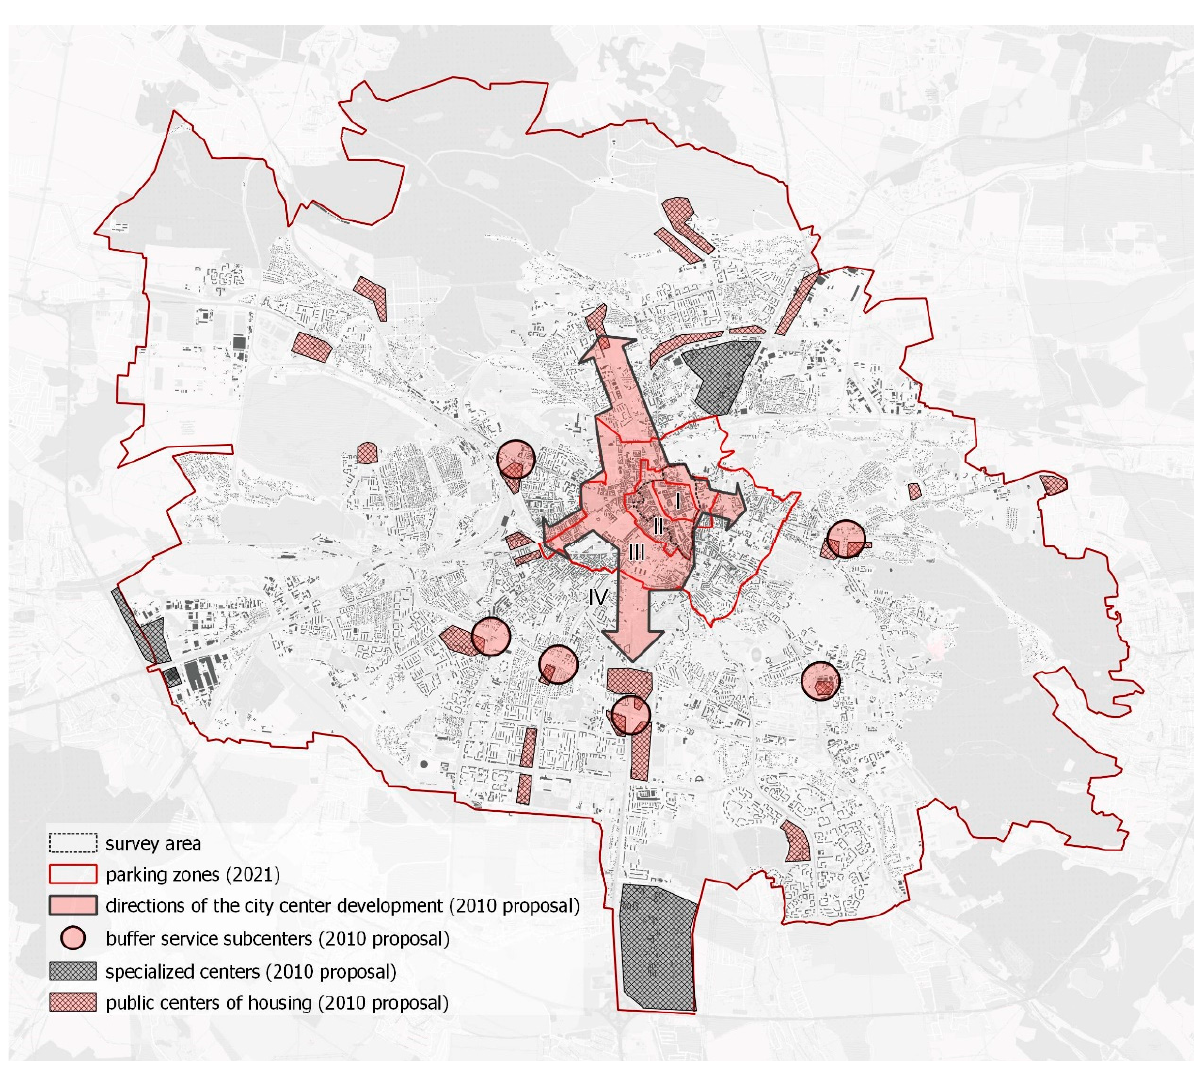
Figure 13 . The directions of territorial development of the city center according to the master plan of Lviv for the period of 2010–2025. The scheme was prepared by the authors using the master plan [68]. The growing density of buildings induces a scarcity of funds for the availability of street parking spaces. During the last decade, there was a construction boom in the largest cities of Ukraine (Kyiv, Kharkiv, Dnipro, Odesa, and Lviv). In the new areas, multi-story residential buildings (9-16-22 floors) have been constructed. Due to the desire of developers to reduce the cost of construction, the new buildings are supplied with much fewer parking spaces than the building codes of Ukraine require. Residents must park their cars on the nearby